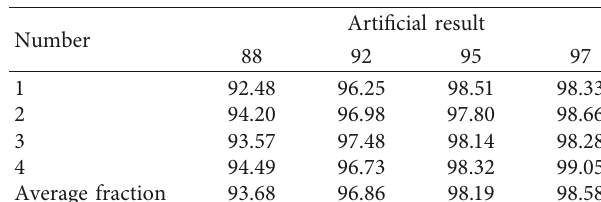
Table 2: Results on the cube texture fraction based on image processing